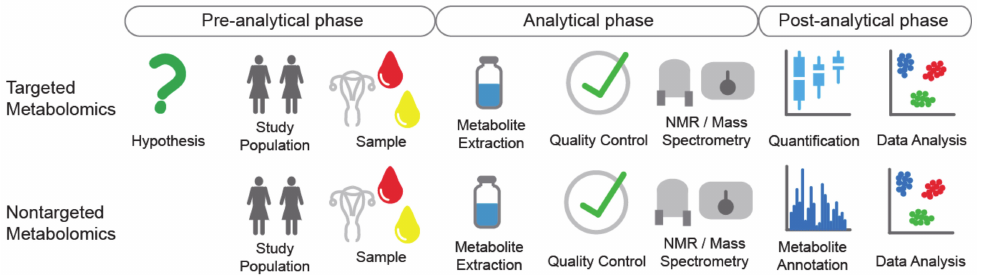
Figure 1. Flow diagram of metabolomics approaches. Targeted and nontargeted metabolomics are both divided into pre-analytical, analytical, and post-analytical